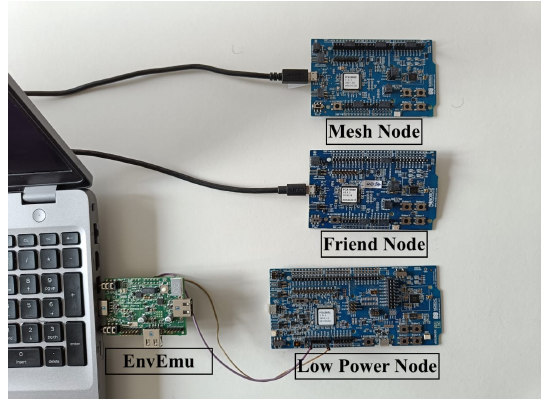
Figure 7. EnvEmu